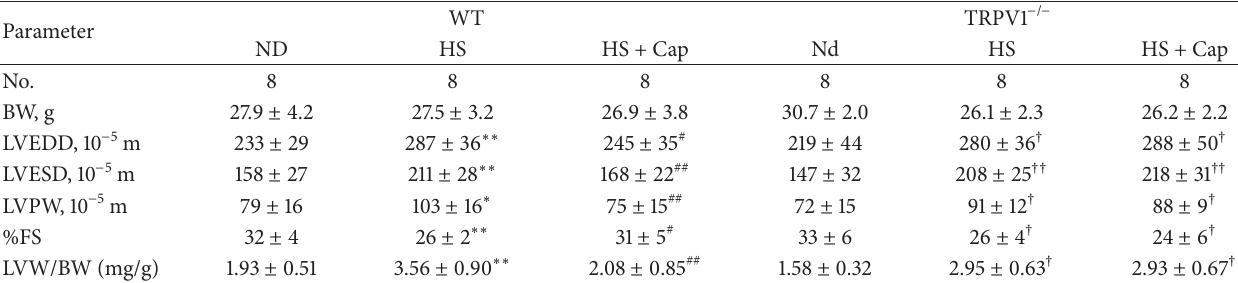
Table 1: Cardiac function from WT and TRPV1 − / − mice on ND, HS or HS + Cap diet for 1 year.